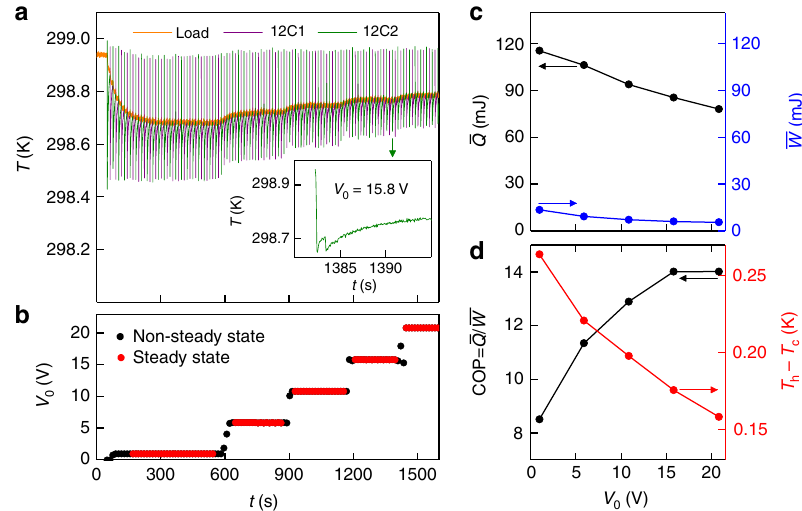
Fig. 6 EC prototype with modi fi ed energy recovery. a Data shown in the fi rst ~600s are similar to the data of Fig. 5d. On subsequently setting ( b ) fi nite values of V 0 , each plate (whose temperature is given by the green or purple data) underwent adiabatic EC cooling in two separate steps, after each of which it slowly absorbed heat from the load, whose temperature T c (orange data) was thus reduced with respect to starting temperature T h . The inset shows a detail of the two-step process for 12C2. For steady-state operation at different values of V 0 (red in b ), we present ( c ) average values of heat Q and work W , and hence ( d ) values of COP = Q = W for each temperature span T h − T c identi fi ed via a . Note that V 0 = 0 prior to initial steady-state operation with V 0 = 0.9